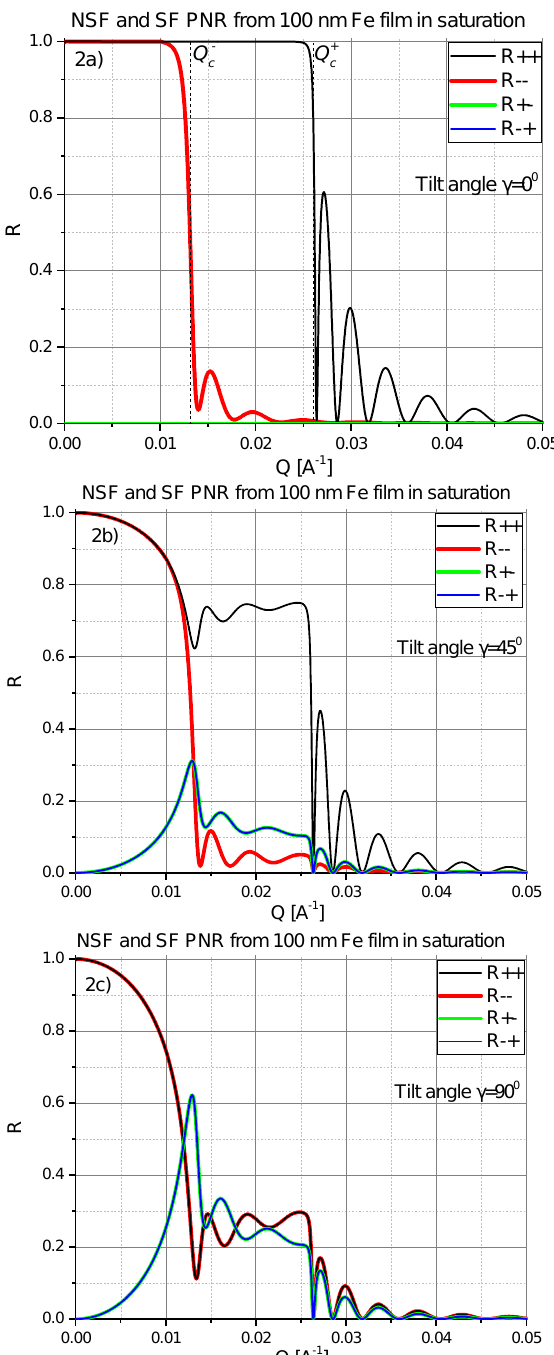
Figure 2. NSF, R ++ (black solid line) and R −− (red solid line), and SF, R + − = R − + (blue lines), reflectivities calculated for a 100 nm homogeneously magnetized iron film on a silicon substrate are shown for the magnetization vector oriented: ( a ) parallel to the axis Y , ( b ) tilted by the angle γ = 45 ◦ and ( c ) for γ = 90 ◦ . The positions of the critical reflection edges Q ± c (independent of γ ) are manifested by sharp drops of both NSF reflectivity curves. The position Q − c in ( b , c ) is confirmed by the sharp maximum in SF reflectivities. Here Q is the modulus of the scattering vector defined by: Q = ( 4 π / λ ) sin α